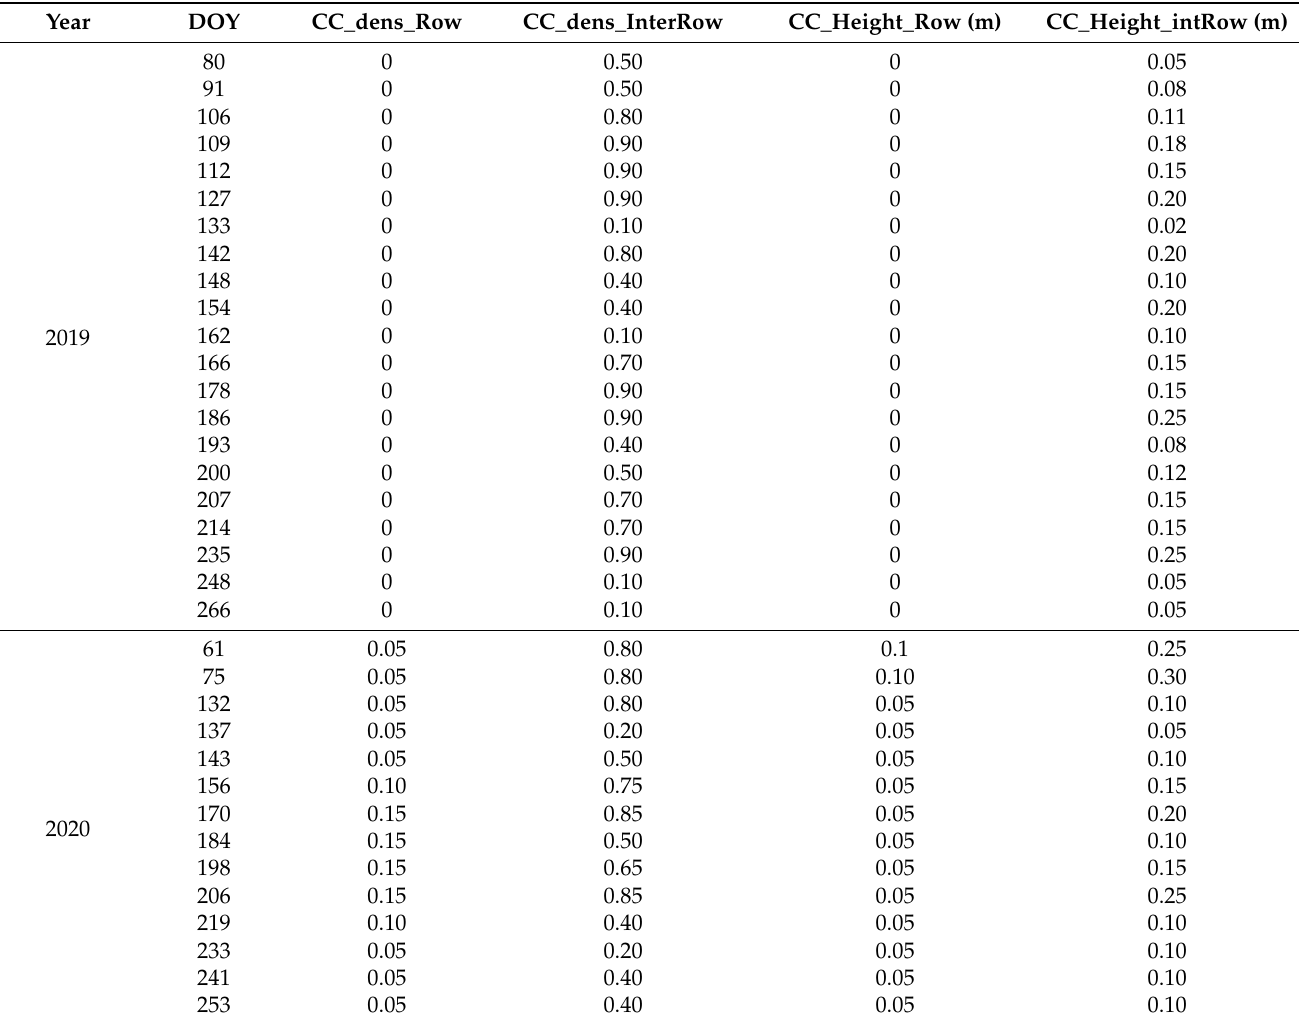
Table A1. Density and height of the green active ground cover for the 2 experimental seasons (2019–2020). Row and inter-row